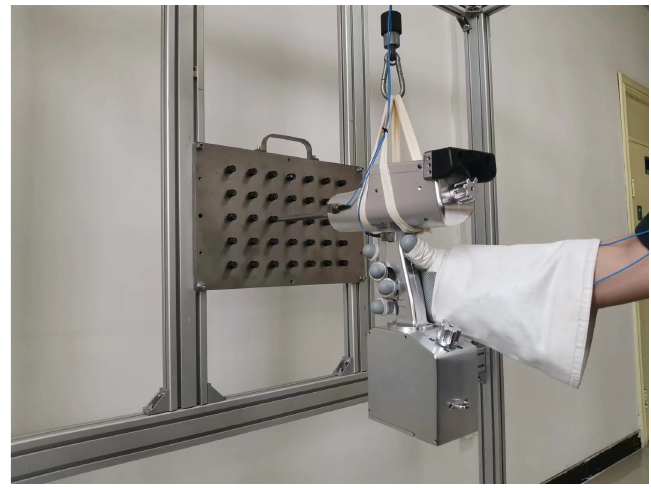
Figure 1. Use the PPT tool to tighten and loosen the non-detaching fastening devices on the hand- transmitted vibration zero-gravity simulation test